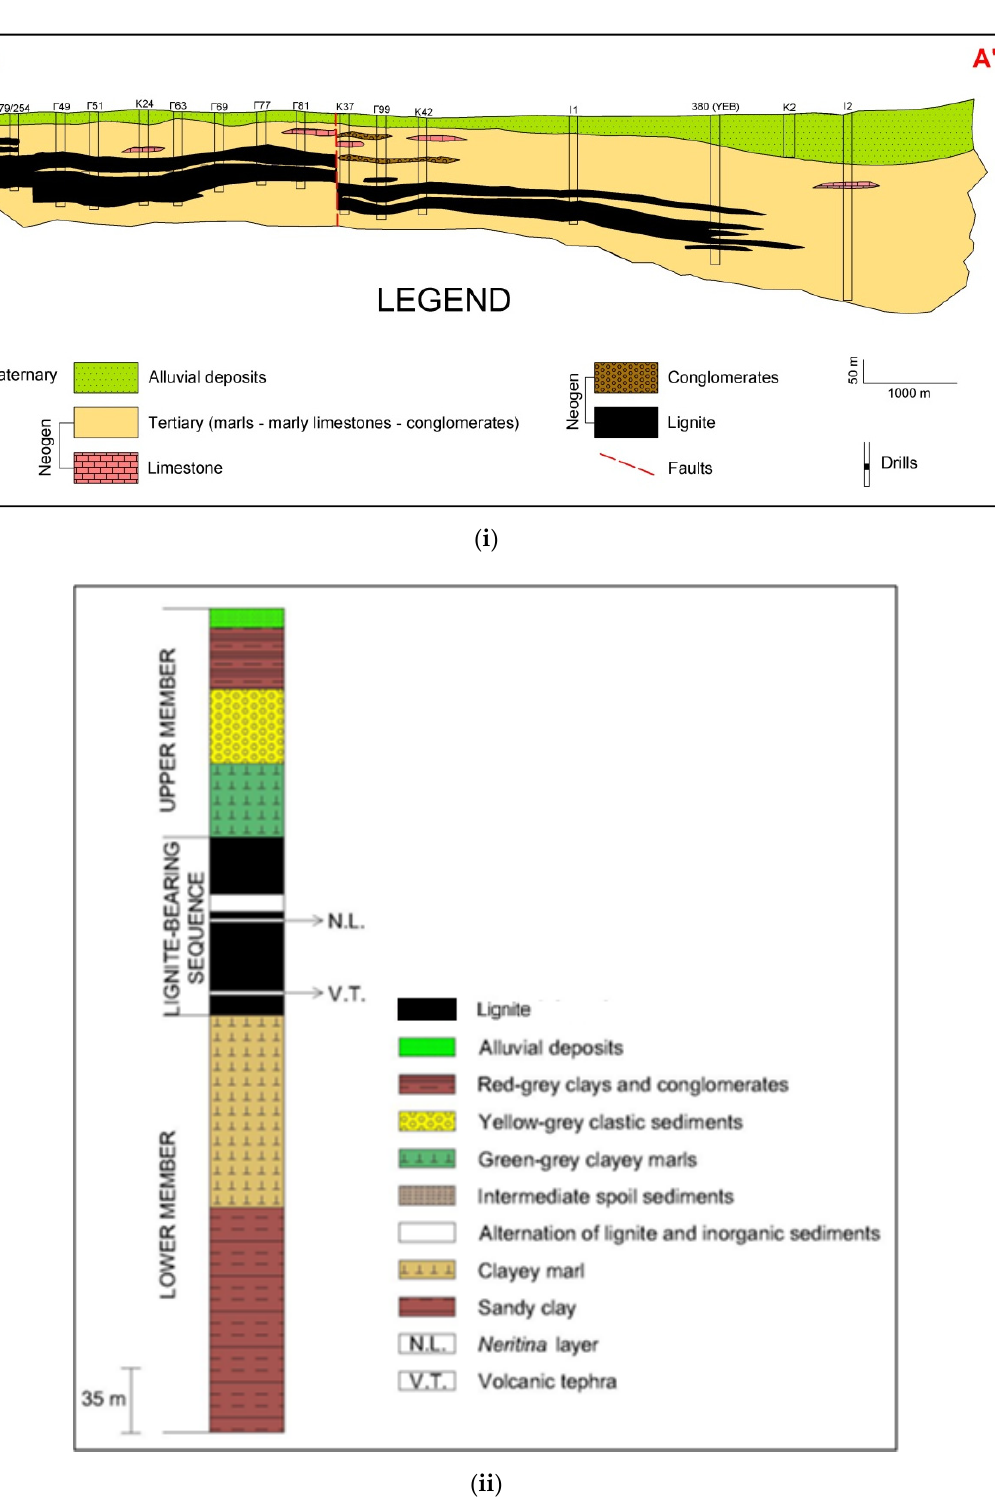
Figure 4. Geological setting of the South Field mine, ( i ) typical geological section AA’ (the trace of cross-section AA’ is presented in Figure 3), ( ii ) stratigraphic column (modified from Roumpos et al. [1]). Water outlets from the coarsely clastic sediments have been observed in the opencast mine.